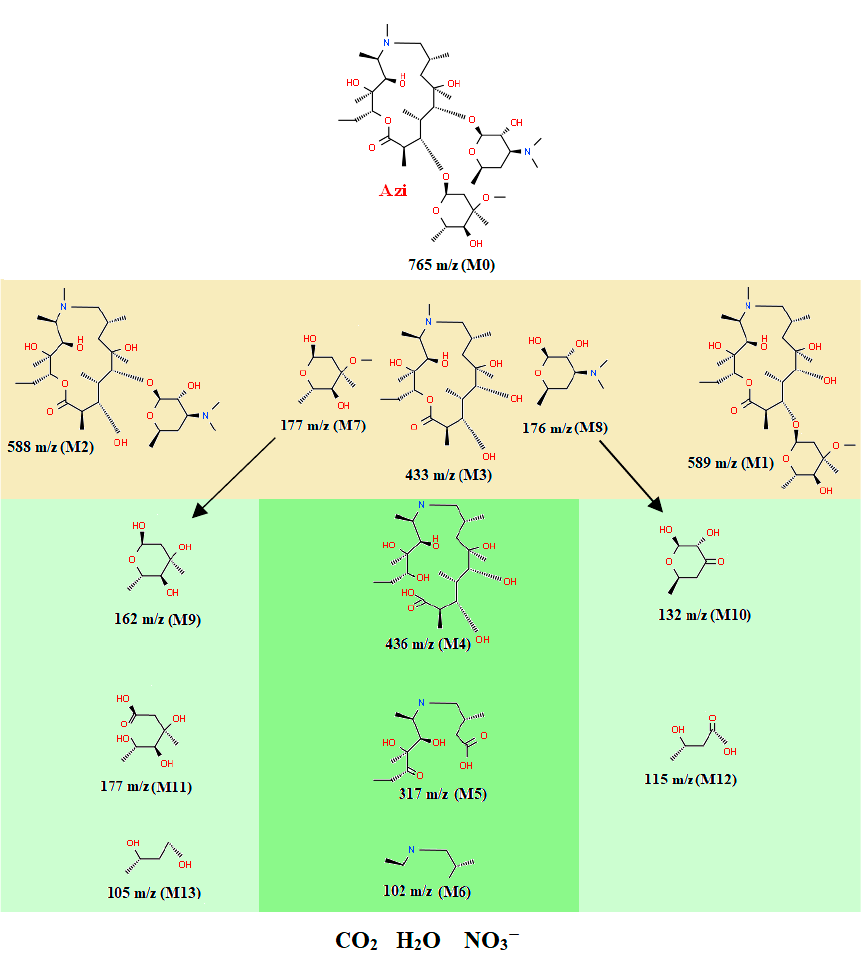
Figure 12. The removal pathway of Azi in the Mn-BTC arg /Al-H 2 O 2